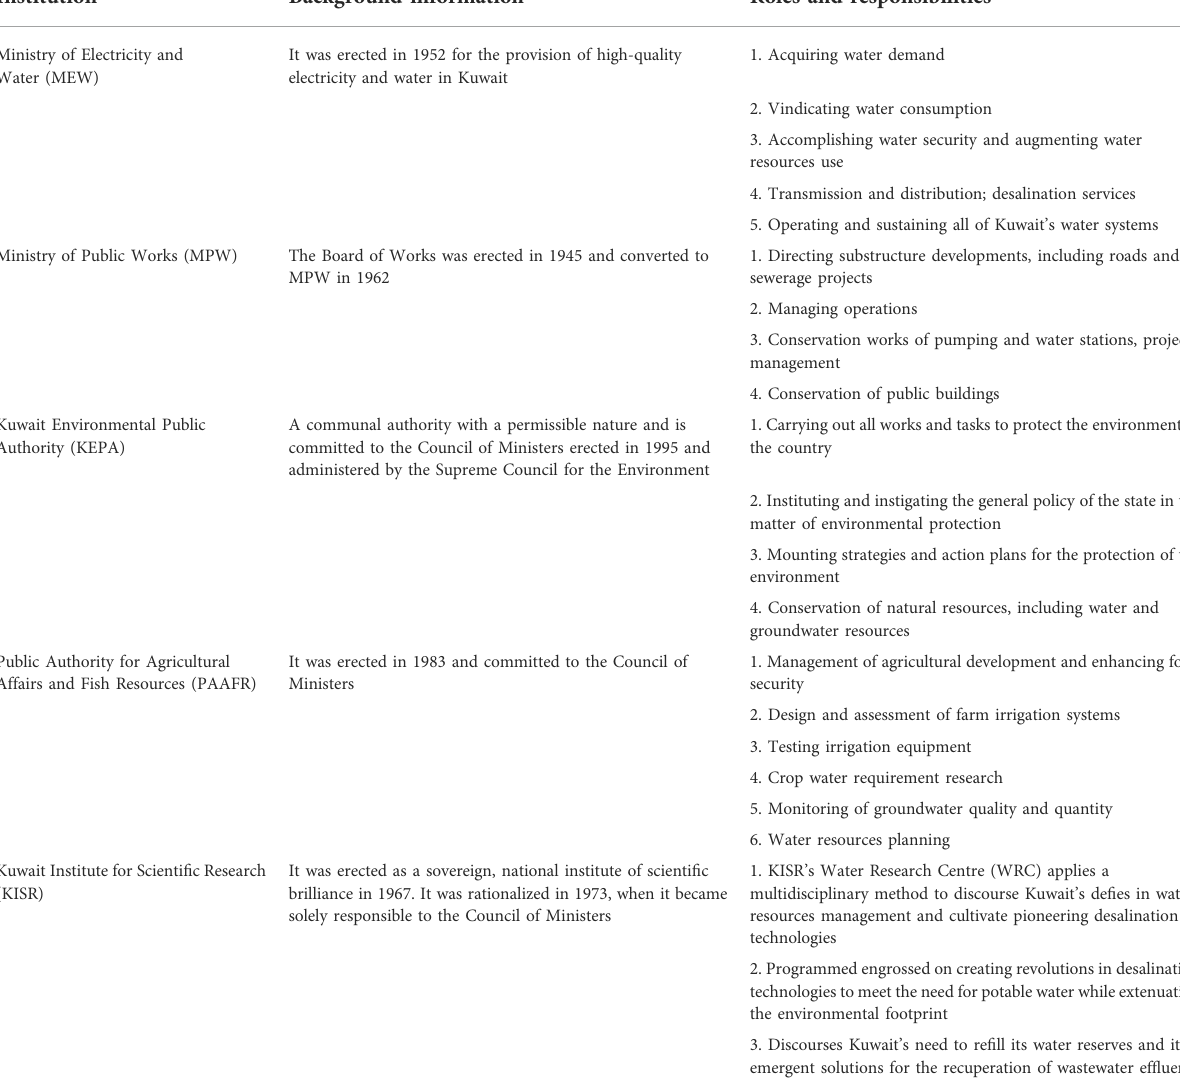
TABLE 4 Background information and roles and responsibilities of